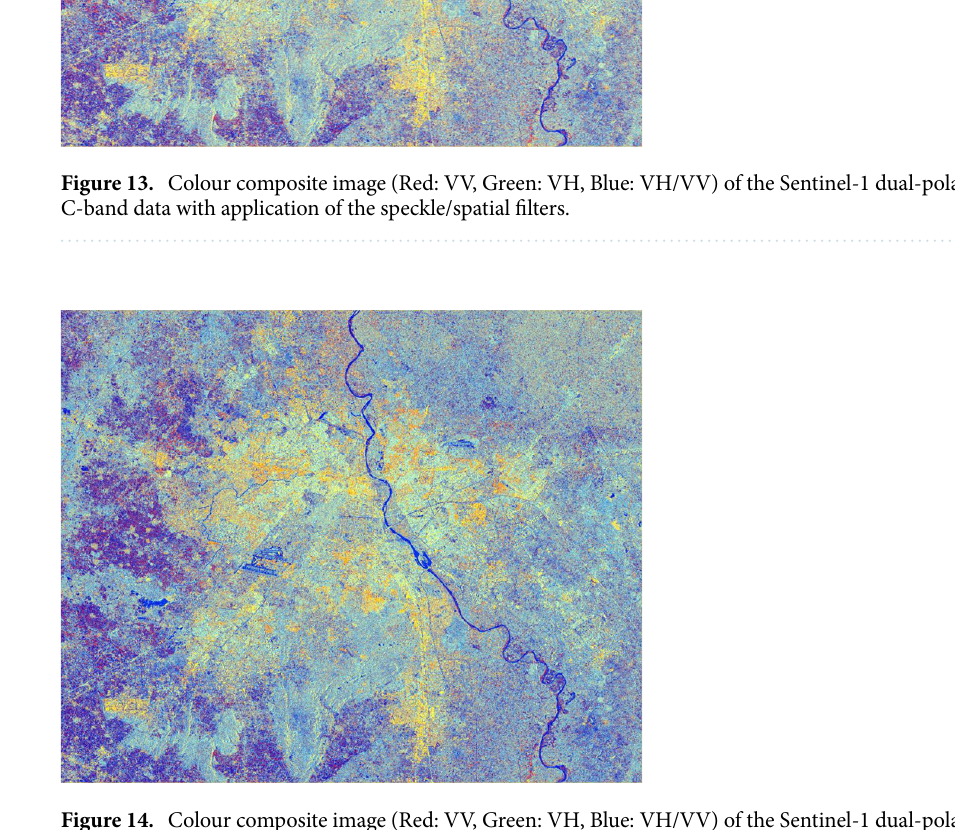
Figure 14. Colour composite image (Red: VV, Green: VH, Blue: VH/VV) of the Sentinel-1 dual-polarization C-band data in with a window size of 5 and sigma value of